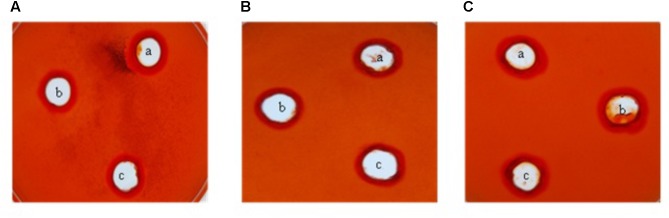
Cysteine protease hydrolytic activity assay in Streptococcus pyogenes NBMKU12 isolate. (A) Casein agar, (B) Papaya agar, (C) Pineapple agar (a: 24 h, b: 36 h, c: 48 h incubated culture filtrates).